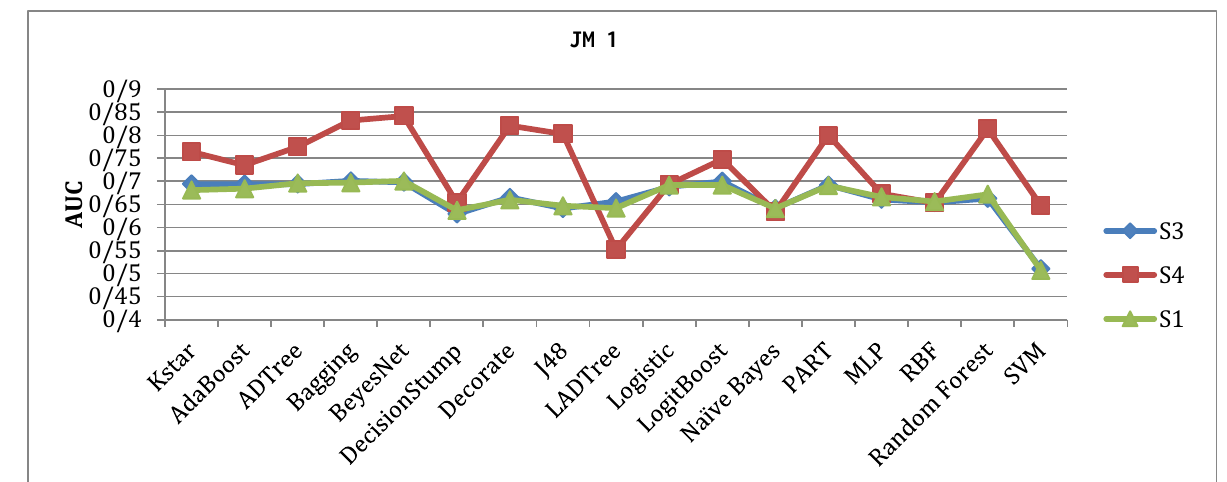
Figure 5. Performance evaluation of 17 data classifiers for JM1